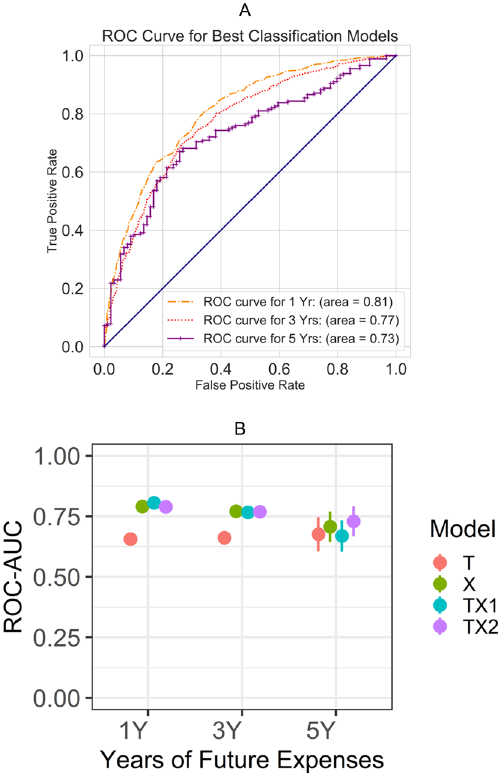
Figure 2. ( A ) ROC Curves for the four classification models. ( B ) Whisker plot of ROC-AUC of top-50% spender classifications within 1, 3, and 5 years. Note that the four models include (T) baseline model that relies only on patient sex, age, and ZIP code median income as input, (X) ResNet with only CXR as input, (TX1) separately trained T and X model combined at final stage, and (TX2) modified ResNet trained end to end with CXR, age, sex, and per-ZIP code median income as